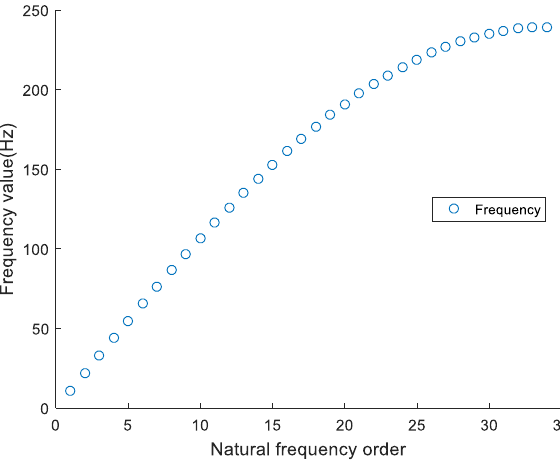
Figure 3. Natural frequencies of each order.